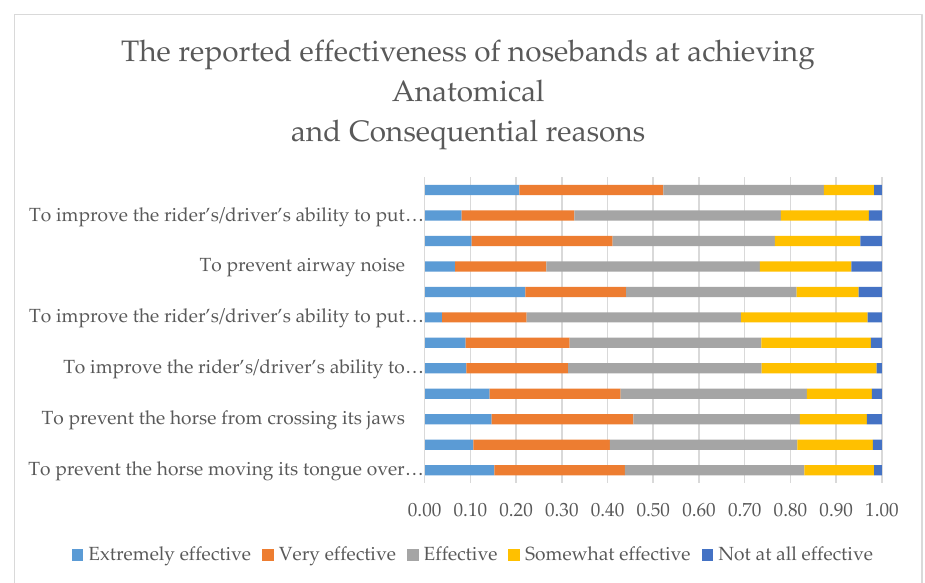
Figure 1. The reported relative effectiveness of nosebands at fulfilling the Anatomical (first four listed reasons) and Consequential (the next eight) reasons for their use. Anatomical reasons for noseband use: To prevent the horse moving its tongue over the bit , To prevent the horse opening its mouth , To prevent the horse crossing its jaws and To prevent the bit sliding through the horse’s mouth . Consequential reasons for noseband use: To improve the riders / drivers ability to decelerate the horse , To improve the riders / drivers ability to steer the horse , To improve the riders / drivers ability to put the horse on the bit or in a frame / outline , To prevent or reduce airway obstruction , To prevent or reduce airway noise , To improve performance in competition , To improve the horse’s acceptance of the bit / contact and To improve the appearance of the horse . E ff ectiveness was reported 3040 times by respondents who used nosebands ( n = 2332).